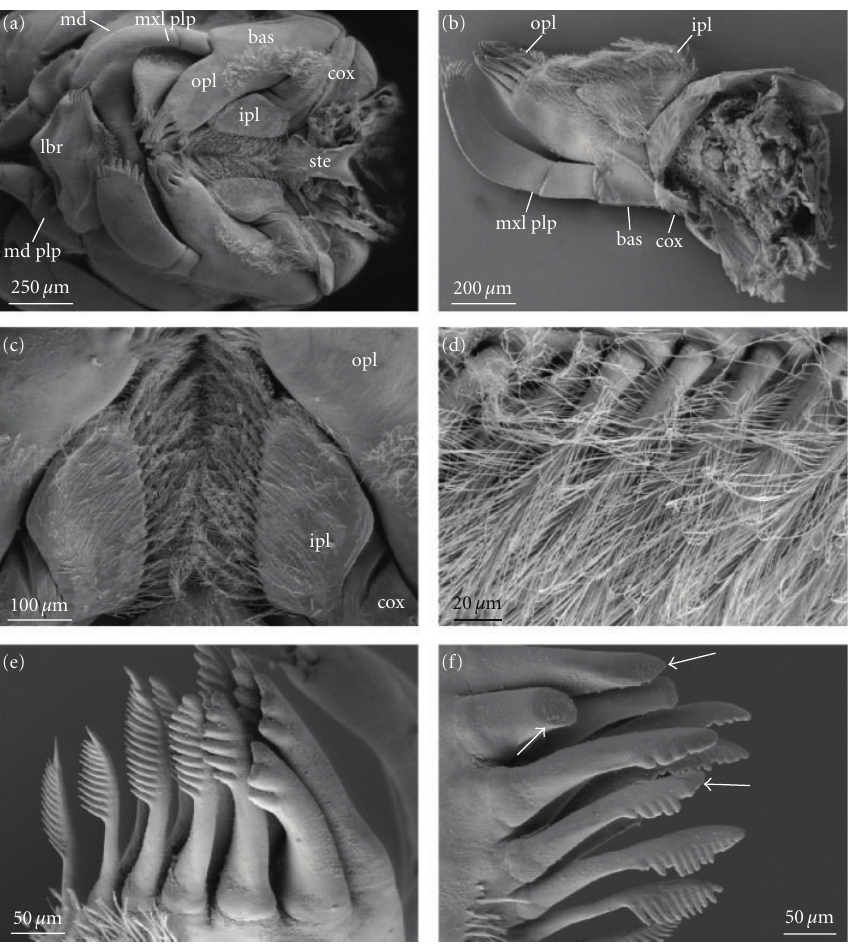
Figure 12: SEM images of maxillulae of Gammarus fossarum : (a) maxillulae in situ in posterior view; (b) left maxillula in anterior view; (c) inner plates of maxillulae in situ in posterior view; (d) median setation of inner plate of left maxillula in posterior view; (e) distal setation of outer plate of left maxillula in posterior view; (f) distal setation of outer plate of right maxillula in posterior view. Arrows indicate signs of